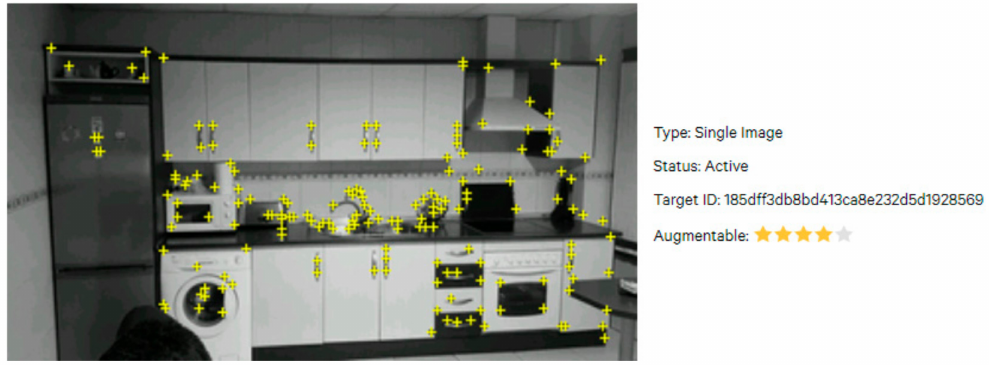
Figure 4. Kitchen image target and its features